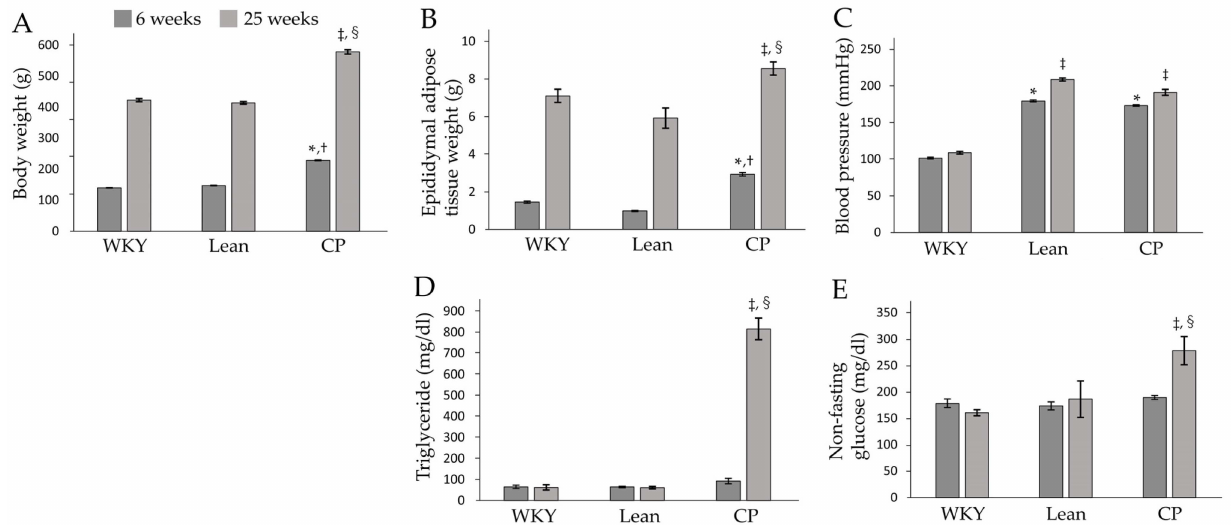
Figure 1. Body and epididymal adipose tissue weights, blood pressure and plasma biochemical data. ( A ) Body weight, ( B ) epididymal adipose tissue weight, ( C ) blood pressure, and plasma levels of ( D ) triglyceride and ( E ) non-fasting glucose in WKY, Lean and CP rats at 6 and 25 weeks of age. Data are mean ± SEM of six rats per group. * p < 0.05, compared with WKY at 6 weeks of age. † p < 0.05, compared with Lean at 6 weeks of age. ‡ p < 0.05, compared with WKY at 25 weeks of age. § p < 0.05, compared with Lean at 25 weeks of age. WKY, Wistar Kyoto rats; Lean, spontaneously hypertensive rats/lean; CP, spontaneously hypertensive